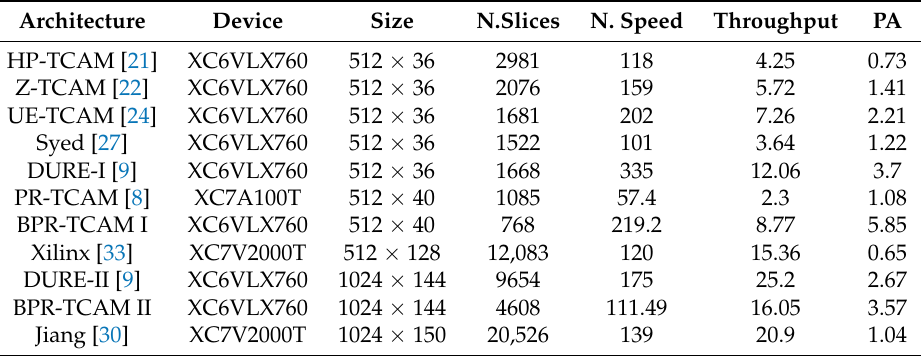
Table 3. Throughput (Throughput in Gbit/s) and Performance Per Area (PA in (Mbit/s)/Slice) comparison of BPR-TCAM with state-of-the-art